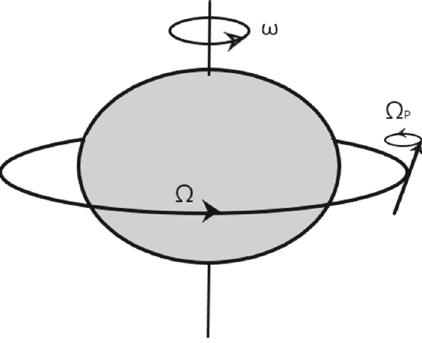
Fig. 1 Sketch of a test gyro orbiting with orbital velocity Ω around a rotating NS whose angular velocity is ω . The precession frequency of gyro is Ω